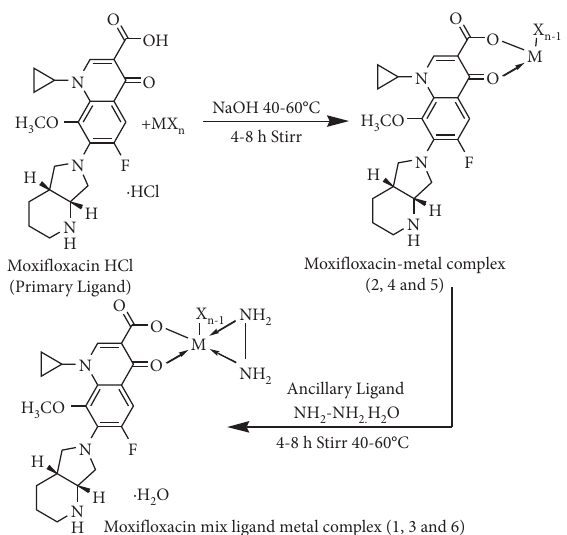
Scheme 1: Synthesis of moxifoxacin metal